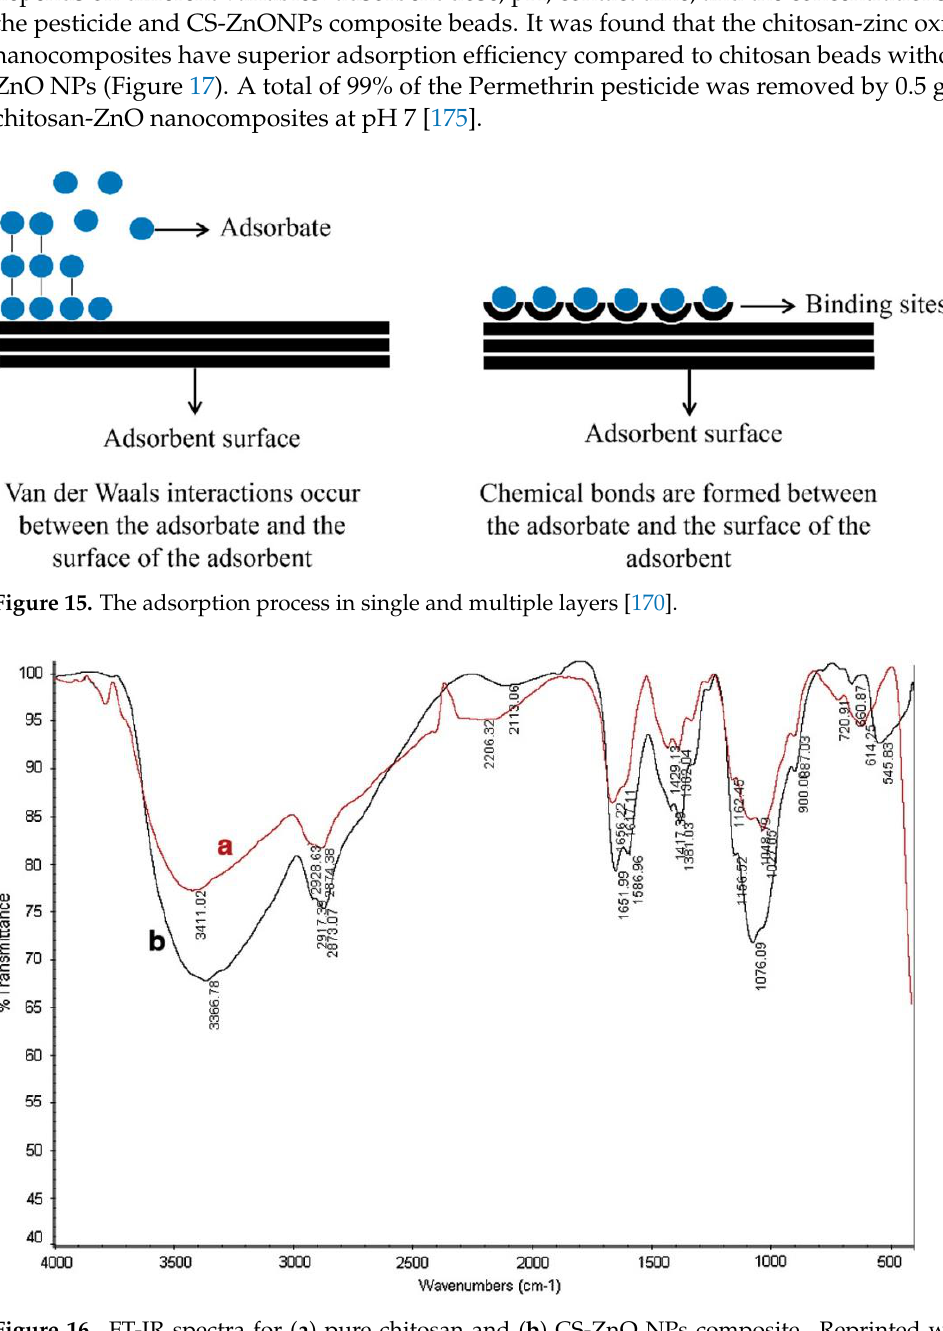
Figure 17. The effect of the amounts of adsorbent on removal percentage of Permethrin pesticide. Reprinted with permission from Ref. [175]. Copyright 2014 Elsevier. 4. Heavy Metals Heavy metals, such as mercury, arsenic, cadmium, lead, and copper, are chemicals that are five times denser than water and have negative impacts on both plants and ani- mals [176]. These are substances with qualities like heat conductivity, current flow, and a lustrous surface. They are present everywhere in nature, but where they are concentrated might change. Many organs in both plants and humans, in very small amounts, need these heavy metals to perform their normal functions. However, when their concentration ex- ceeds the safe limit, they become hazardous. They are on the list of significant contami- nants and worries about them are growing daily [177,178]. Pesticides, insecticides [179], municipal sewage, industrial effluents, mining, weathering, and erosion caused by wind and water are a few significant sources that make it easier for them to enter the environ- ment [180].